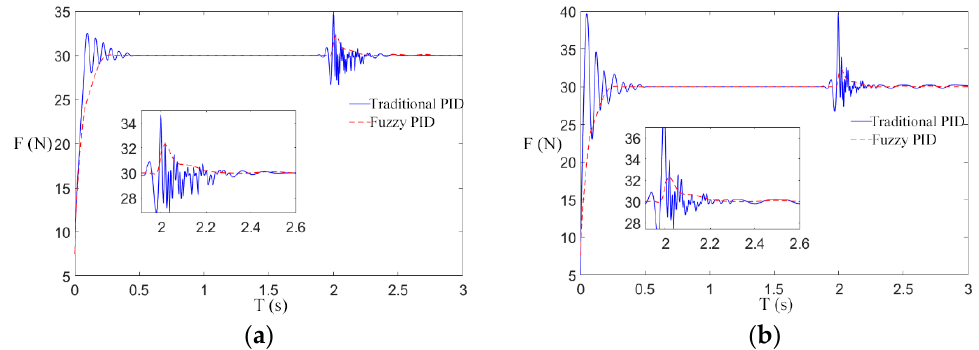
Figure 16. The influence of step when the reference tension is 30 N. ( a ) Situation 1; ( b ) Situation 2.